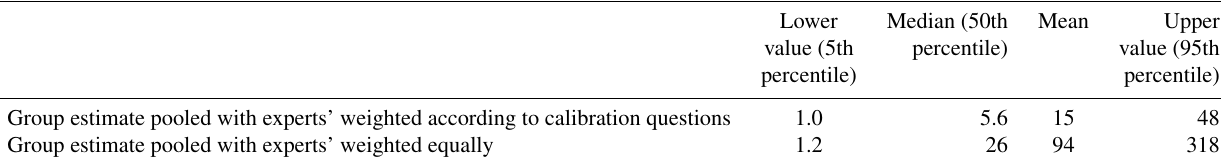
Lower Median (50th Mean Upper value (5th percentile) value (95th percentile) percentile)